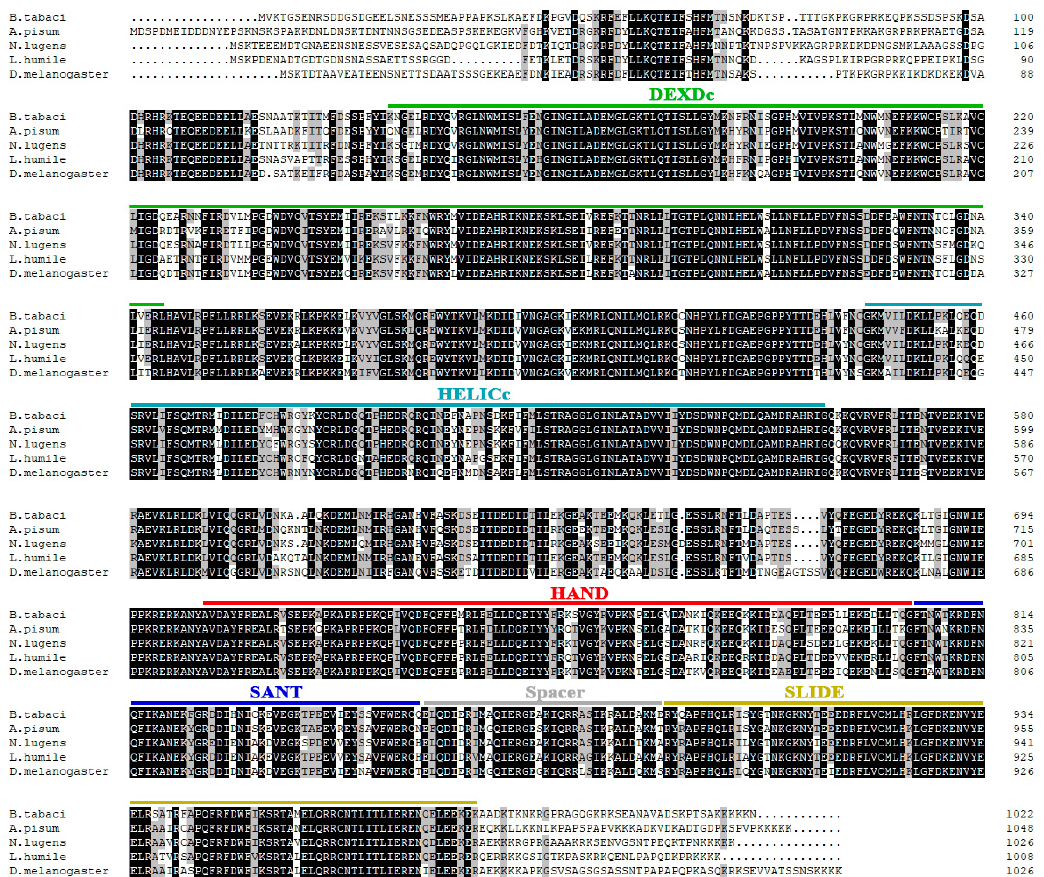
Figure 3. Multiple alignments of the imitation switch (ISWI) protein sequences from Bemisia tabaci MEAM1 and other insects. The conserved domains are highlighted in the same colors as in Figure 2.